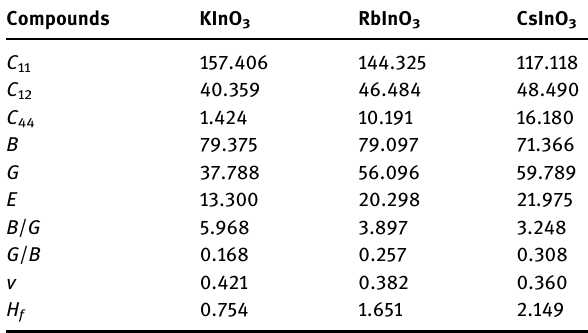
Table 2: Calculated elastic constants ( C ij in GPa ) , bulk, shear,